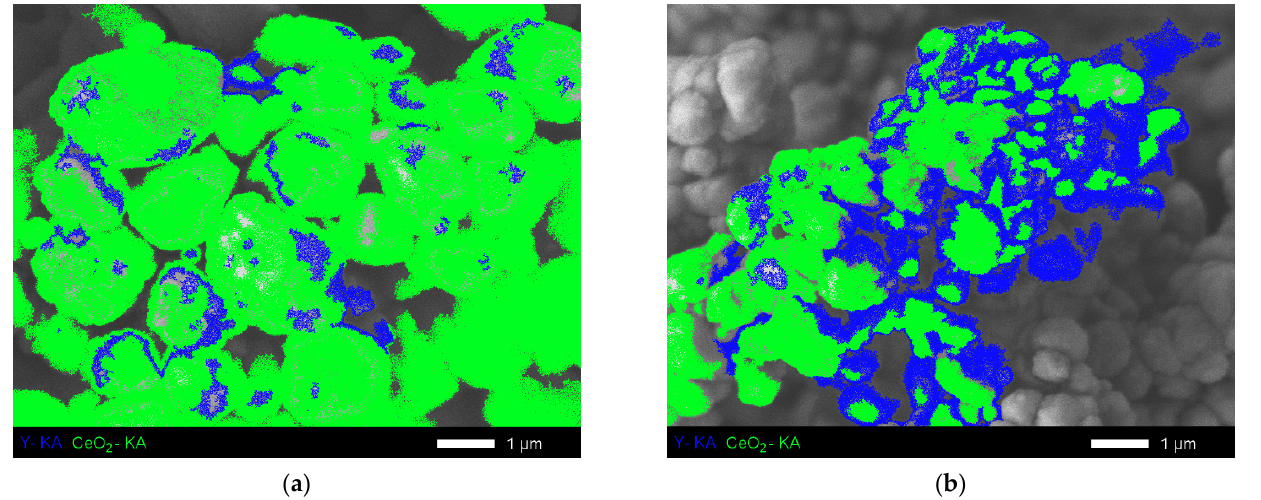
Figure 3. Mapping results: ( a ) 0.15 mol.% sample; ( b ) 0.20 mol.% sample.